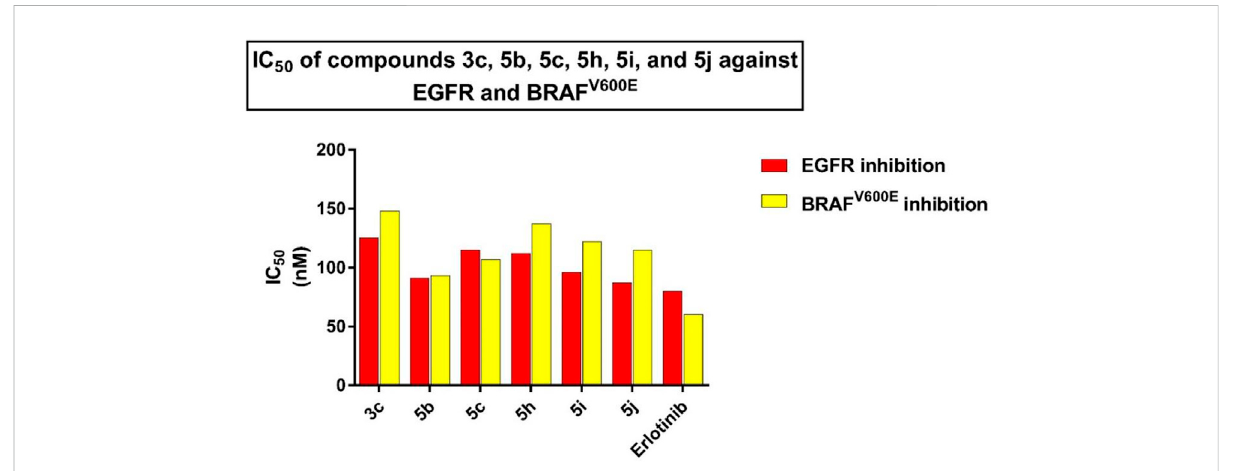
algorithm (LGA) opted for inhibitor conformational